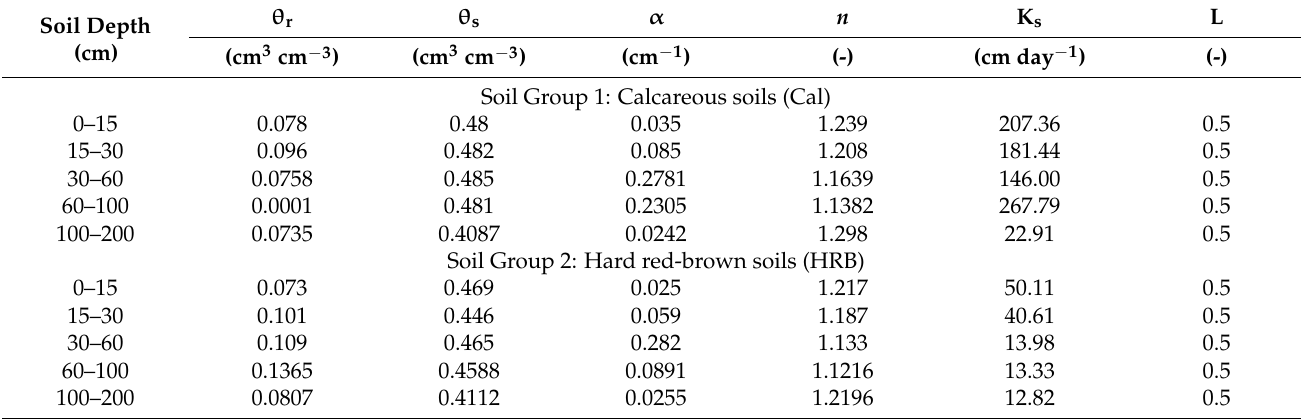
is described in [10]. Values of soil exchangeable cations and Gapon constants for both soils used in the modelling simulations are shown in Table A2. Soil chemical properties (Table A2) measured in the 0–30 cm soil layer were assumed to extend to 200 cm (the domain depth) as the soils had almost uniform texture below 20 cm. Running the model during the warm-up period (48 years) allowed the chemical species to acquire a stable chemical composition in the solution and at the soil exchanger. Table A1. Estimated average soil hydraulic parameters for different soil groups in the study area (from [10]).